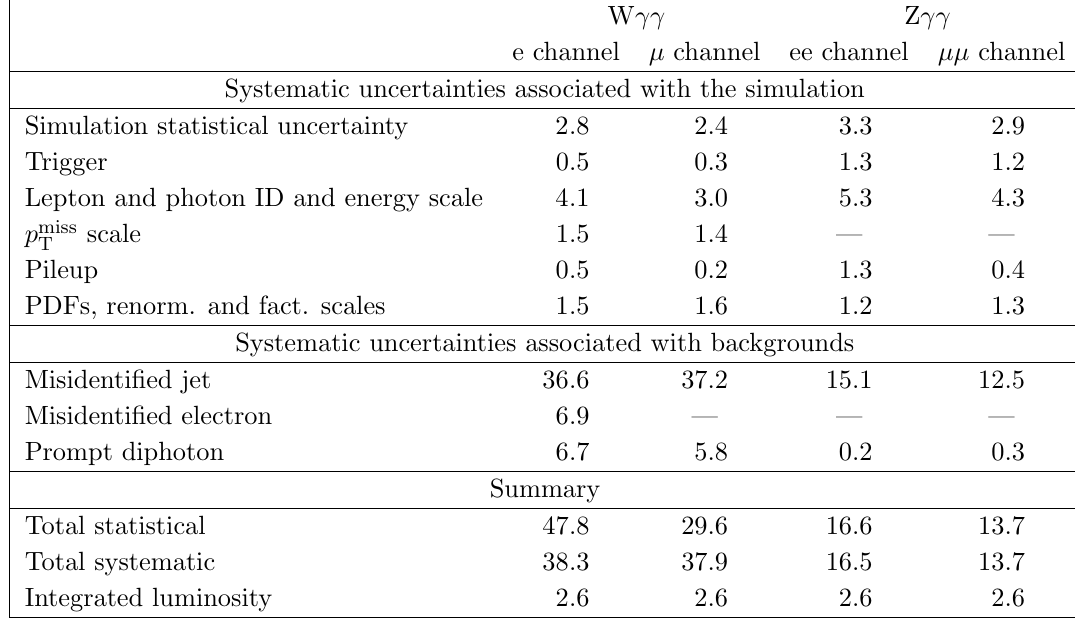
Table 3 . Systematic and statistical uncertainties a(cid:11)ecting the W (cid:13)(cid:13) and Z (cid:13)(cid:13) (cid:12)ducial cross section measurements, presented as percentages of the measured cross